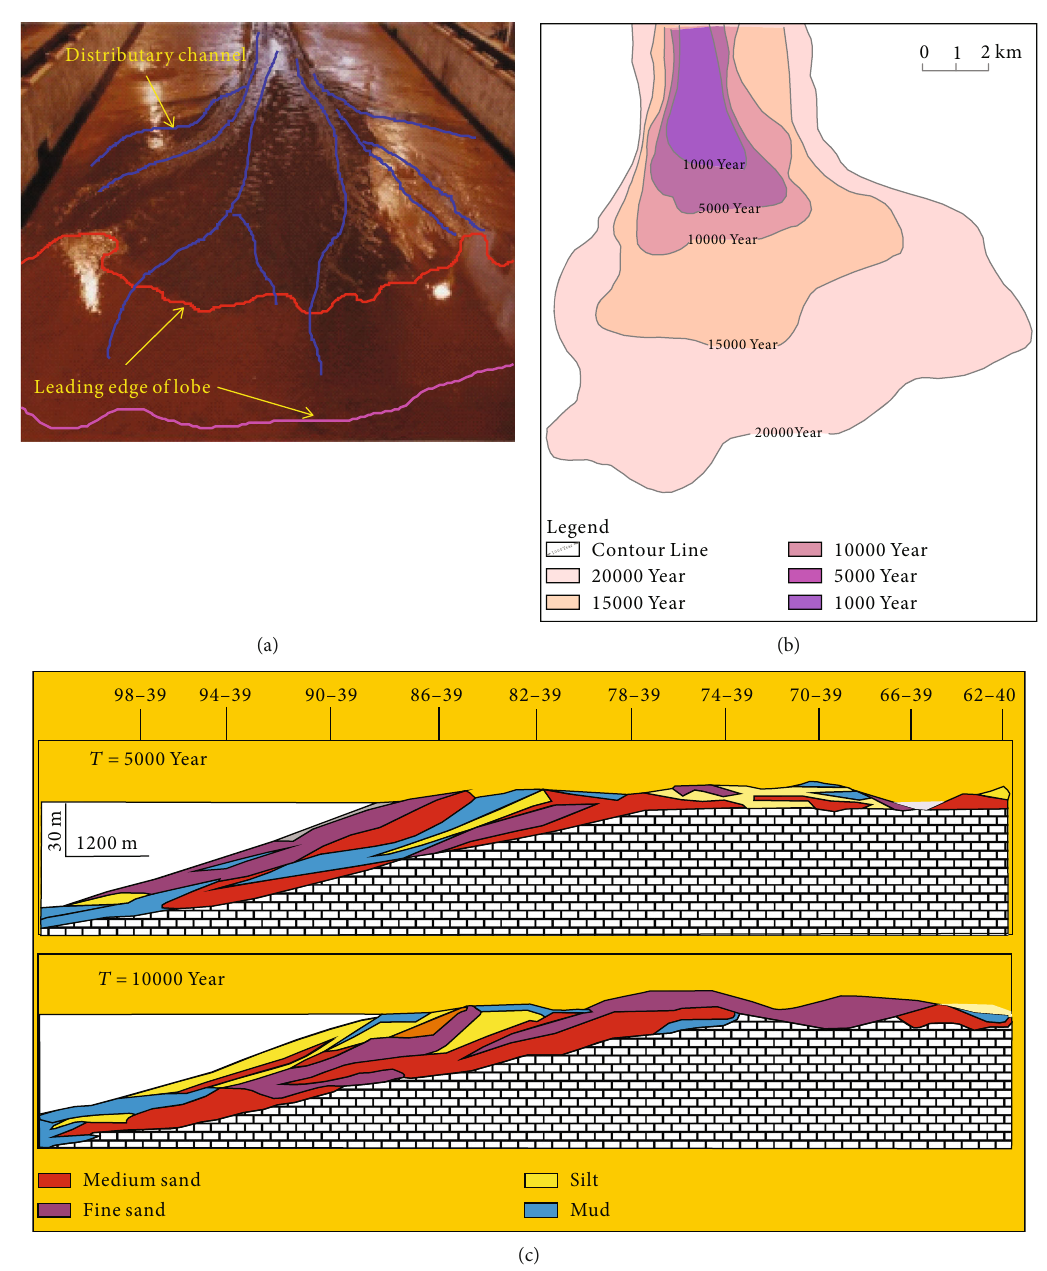
Figure 6: Physical simulation results of delta (Zhang [28]). (a) Photo of delta front sand body obtained from simulation; (b) contour line of delta front sand body development; (c) pro fi le of delta front sand body